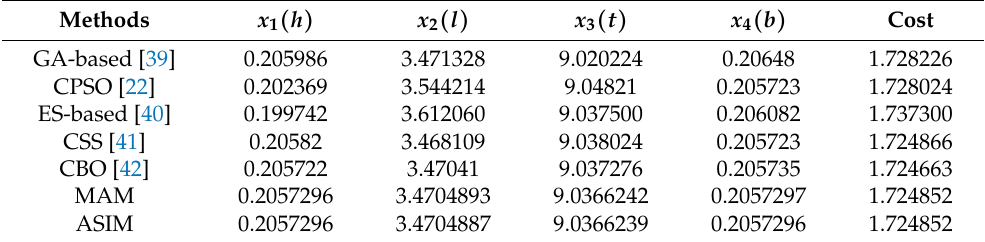
Figure 4. Schematic of the welded beam structure with indication of design variables. Table 3. Comparison of present optimized designs with the literature for welded